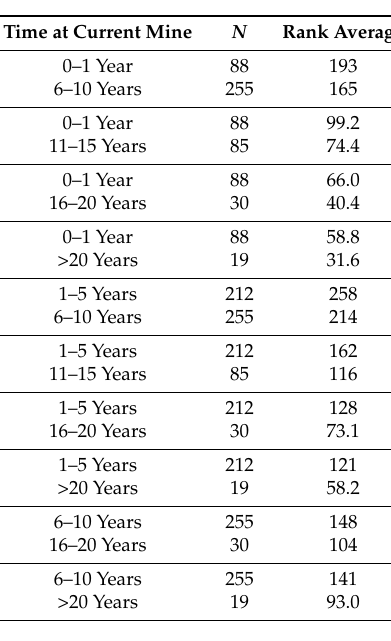
Table A6. Mann-Whitney results for mining experience and confidence in one’s ability to correctly explain or demonstrate “what lifeline symbols